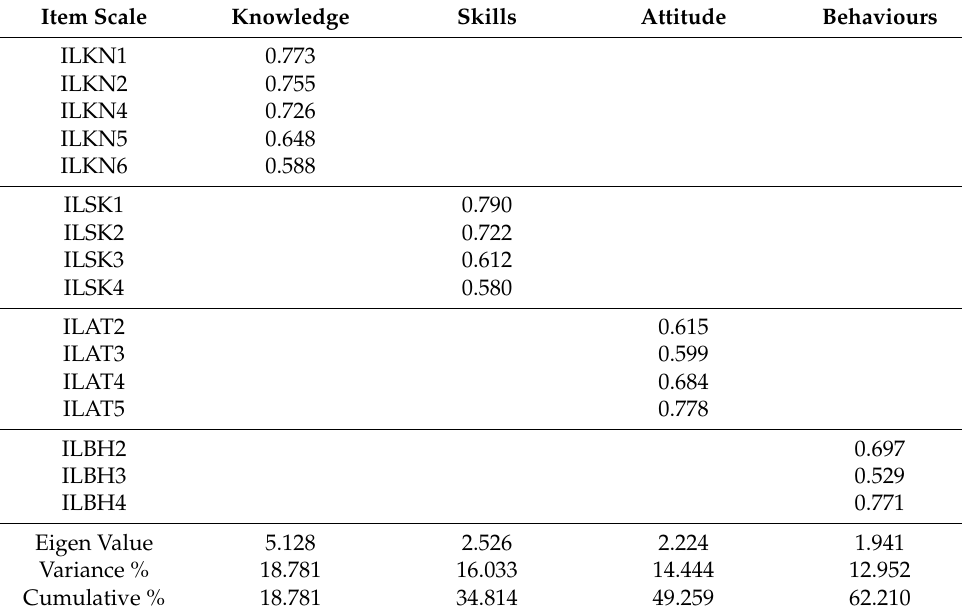
Table 4. Exploratory factor analysis for insurance